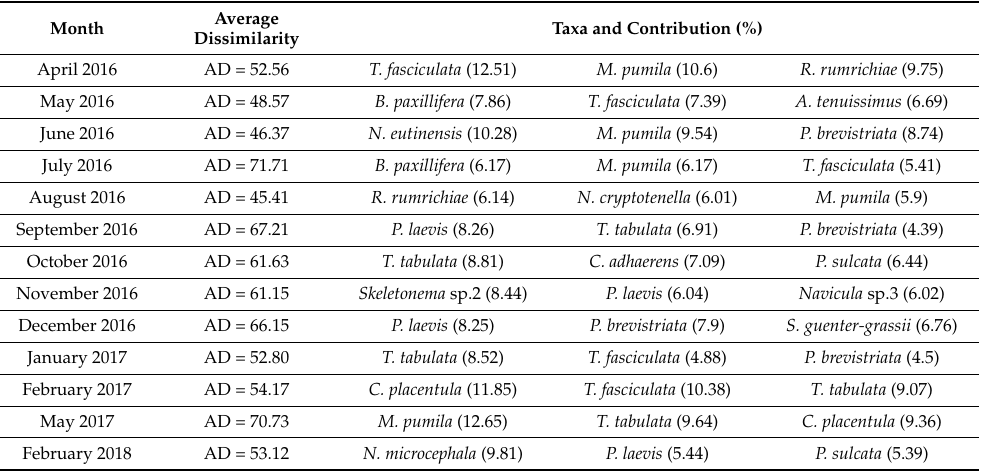
Table 3. SIMPER analysis with the three taxa that most contributed (%) to the dissimilarities between the impacted and non-impacted areas. AD = average dissimilarity.